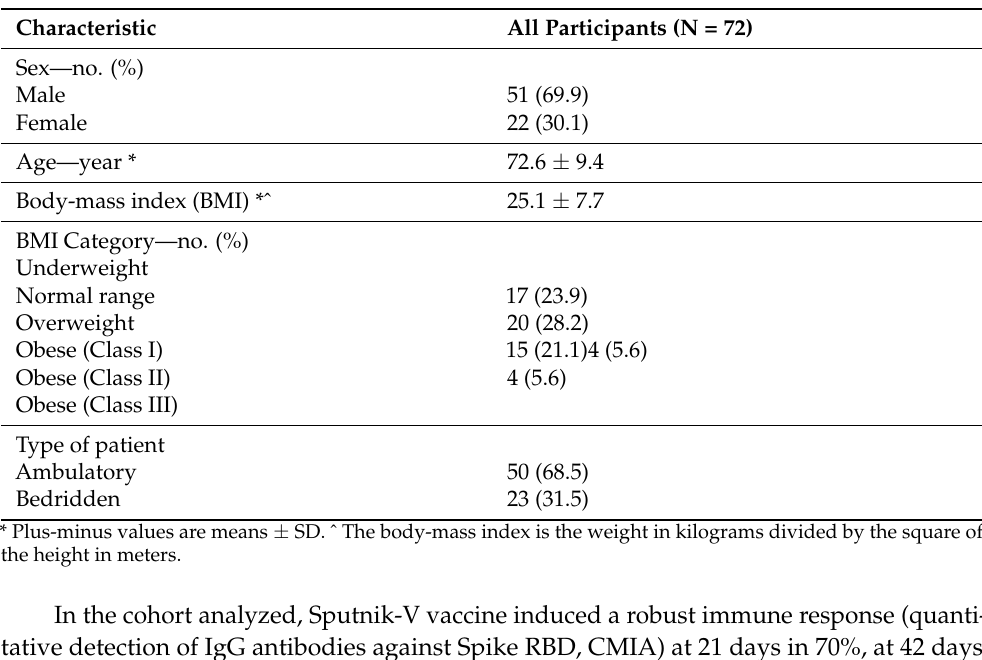
Table 1. Characteristics of the participants at baseline.